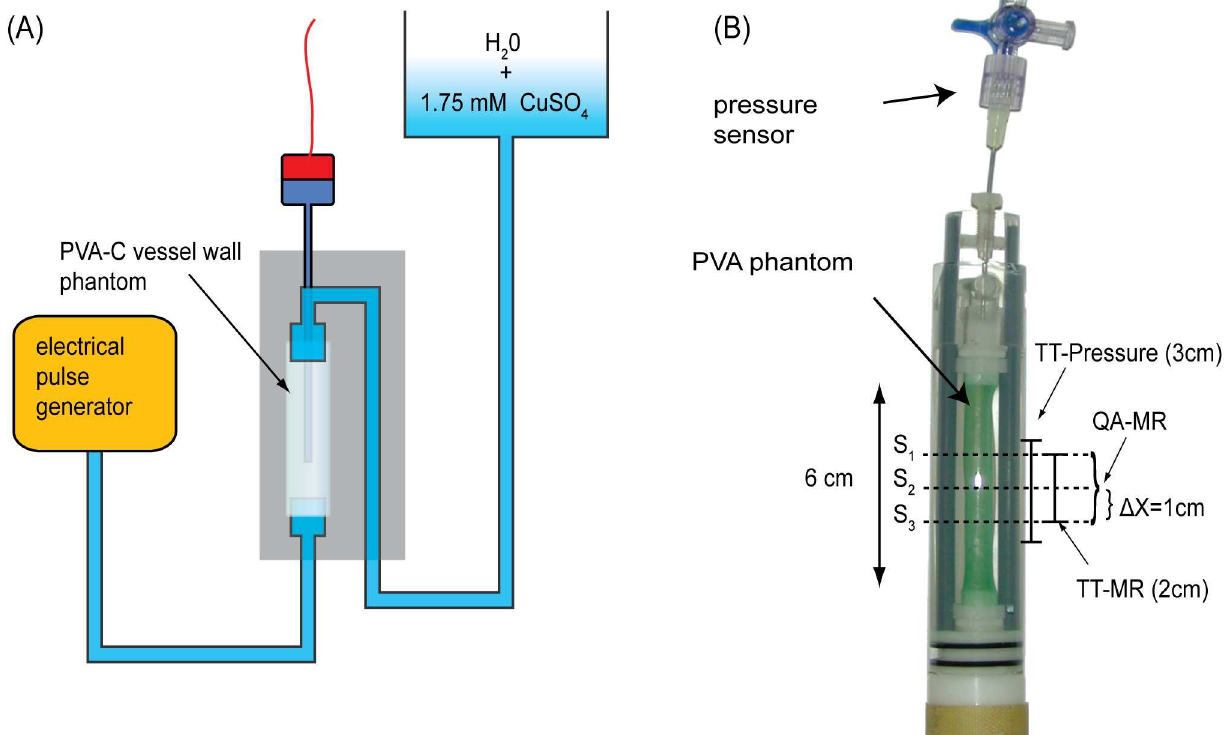
Fig 2. Phantom experimental setup. Panel (A) shows a schematic depictionof the PVA-C phantomwith electricalpulse generatorand pressure sensor. The pulse wave velocity phantomactually mounted is shown in (B) . The sites for the transit-time pressuremeasurements and the transit-time MR measurements as well as the measurement slices for the QA-measurement are